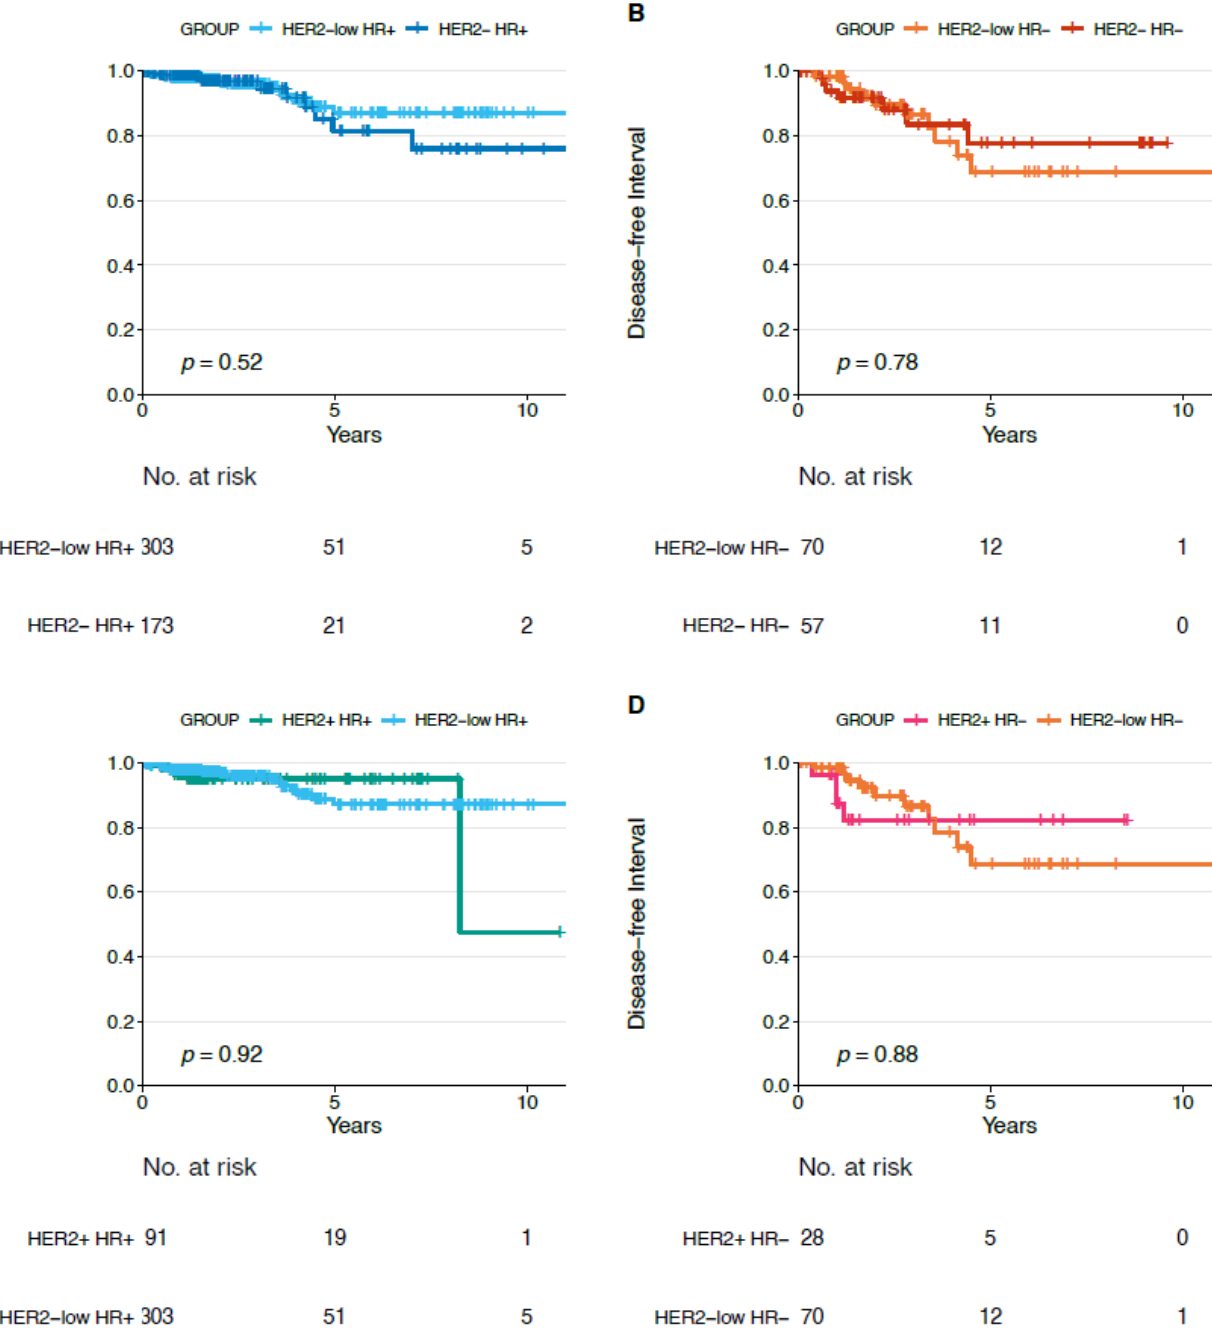
Figure 4. Disease-free interval in HER2-low/HR+ versus HER2−/HR+ ( A ), in HER2-low/HR− versus HER2−/HR− ( B ), in HER2-low/HR+ versus HER2+/HR+ ( C ) and in HER2-low/HR− versus HER2+/HR− ( D ) tumors. Abbreviations: HR: hormone receptor.